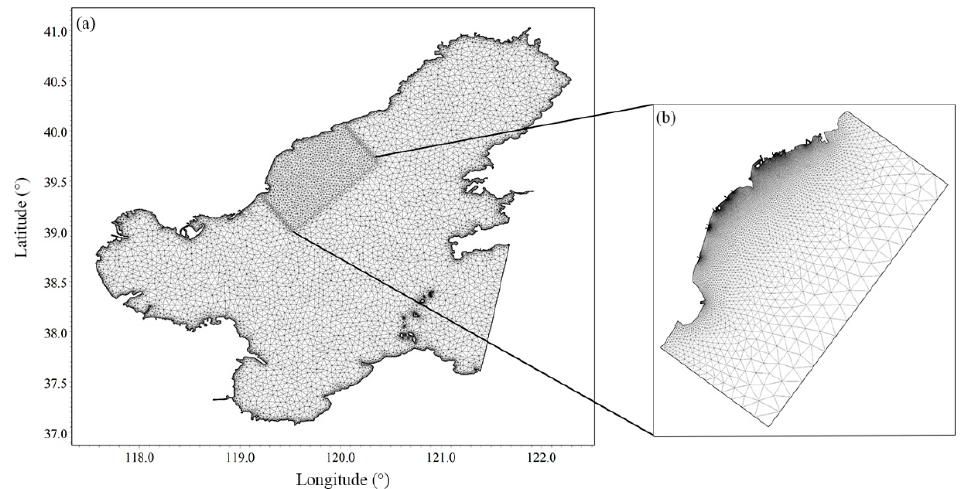
Figure 2. The nested model domain and mesh. ( a ) The regional model domain and mesh of the Bohai Sea; ( b ) The local model domain and mesh of Qinhuangdao.